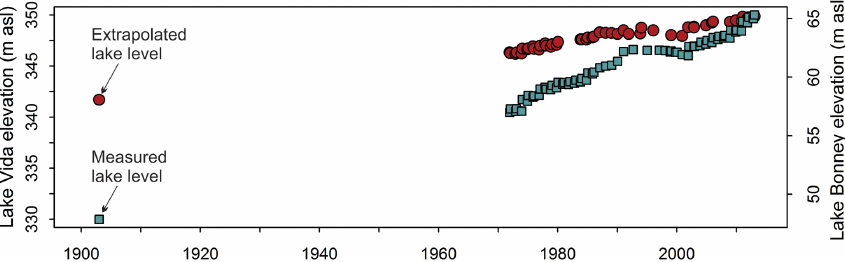
Figure 8. Lake Vida and Lake Bonney surface elevations. The 1903 Lake Bonney elevation is inferred from a measurement at Lake Bonney narrows by Robert Falcon Scott (Chinn, 1993). The 1903 Lake Vida elevation is extrapolated from the correlation between the two lakes for